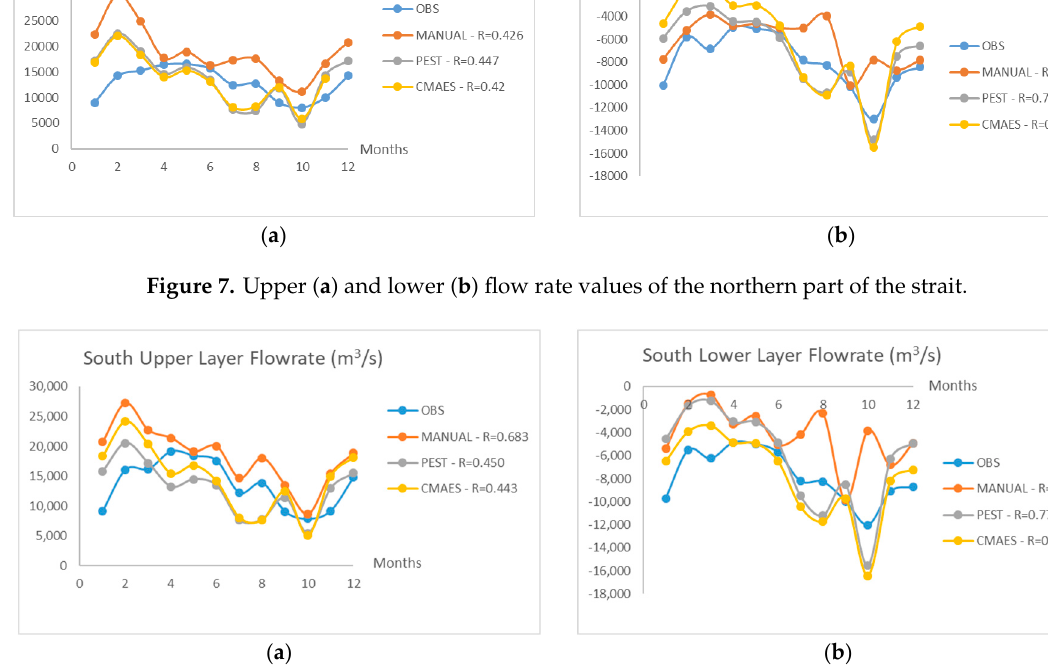
Figure 8. Upper ( a ) and lower ( b ) flow rate values of southern part of the strait.